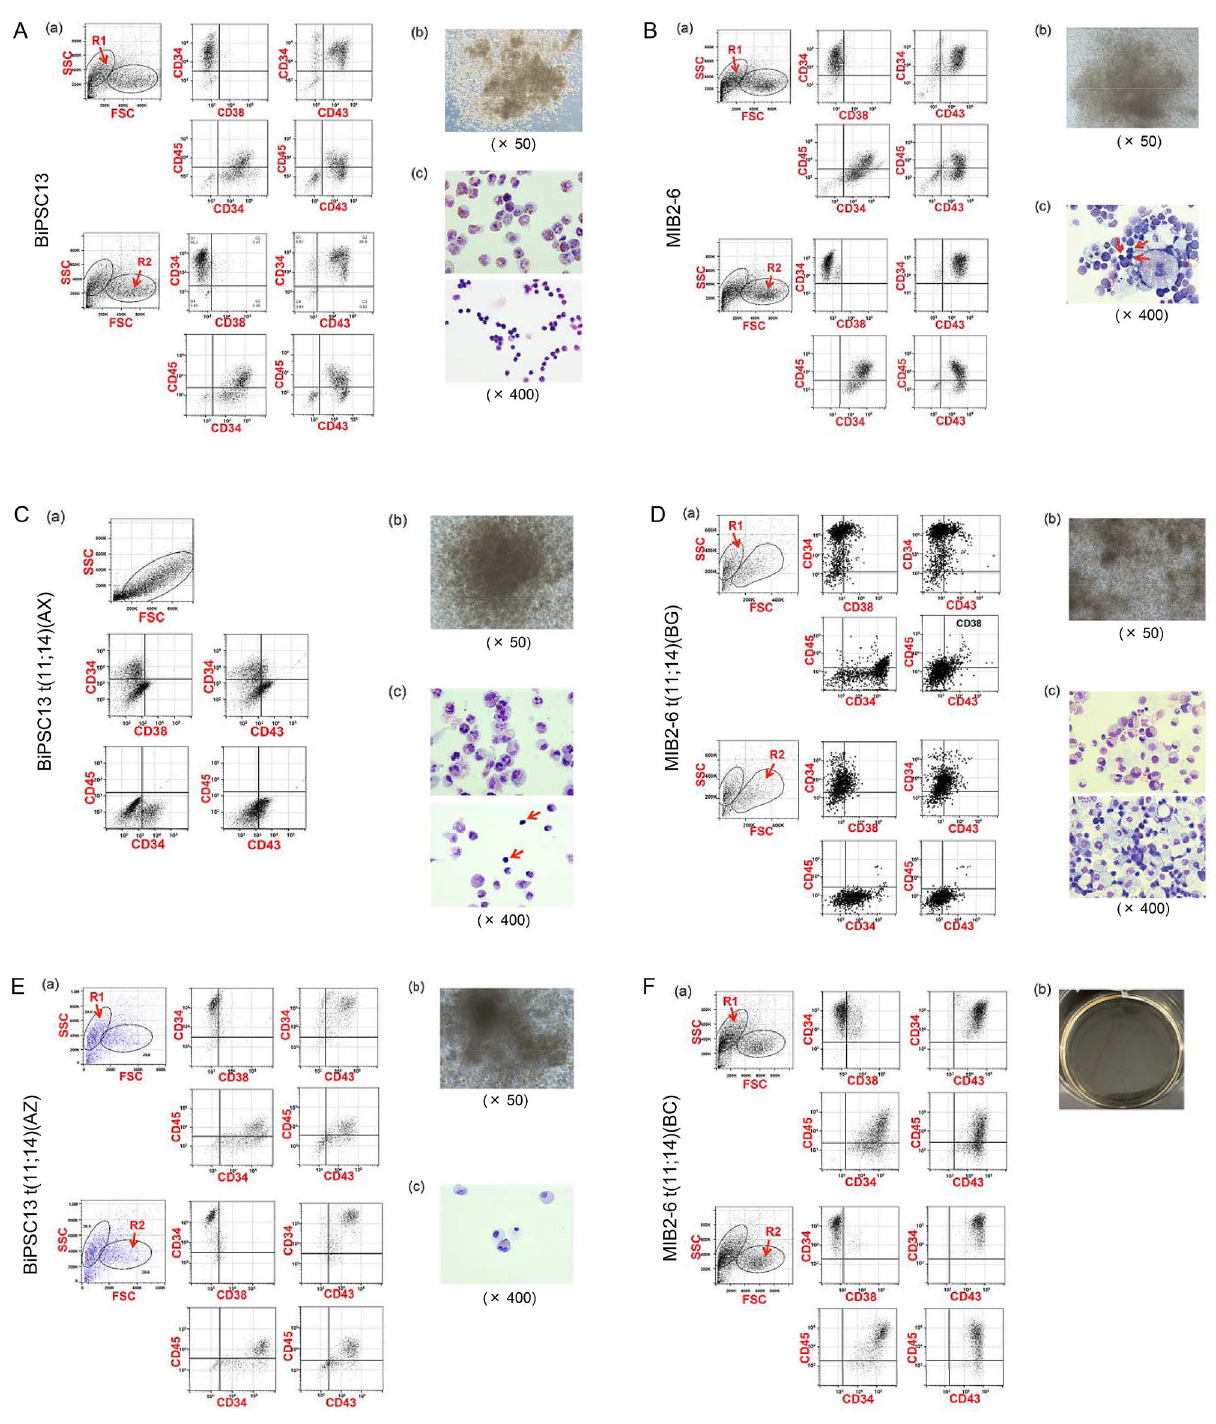
Figure 3. Induction of differentiation of parent BiPSCs and their genome-edited BiPSCs into blood cells. (A) BiPSC13, (B) MIB2-6, (C) AX, (D) BG), (E) AZ, (F) BC, (G) AX with AID, and (H) G#28 with AID. (a) Flow cytometric analysis of the cell phenotype after differentiation of BiPSCs into HPCs. Two cell populations were observed (R1 and R2). (b) Representative morphology of formed colonies (× 50). (c) Wright staining of cytospins picked up from a colony (× 400). The bottom picture of (A) and arrows indicate erythrocytes. The bottom picture of (D) shows a mix of macrophages and erythrocytes. (I) Number of colonies formed. The types of colonies formed were assessed in